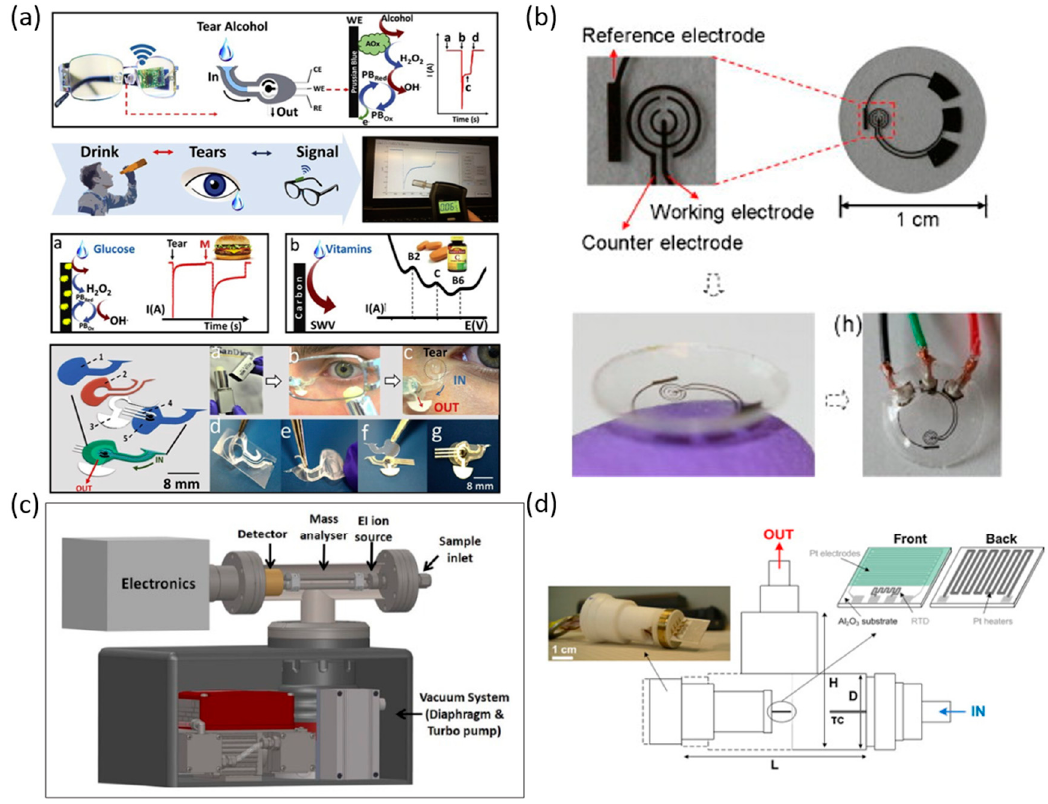
Figure 6. Portable biosensors for tears/breath biomarker detection. ( a ) Eyeglasses-based Fluidic Device [52]. ( b ) Prototype contact biosensor for glucose sensing [53]. ( c ) Schematic diagram of the portable QMS and vacuum system [55]. ( d ) Schematic and image of the portable breath acetone monitor with Si:WO3 gas sensors [56].